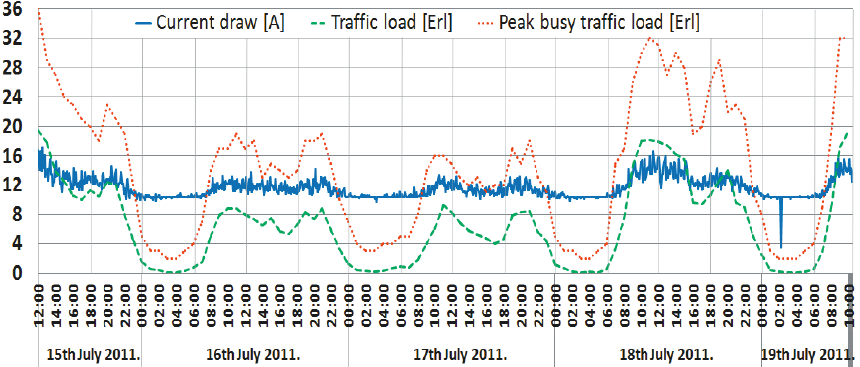
Figure 9. Comparison between electric current draw and traffic load for GSM BS (Sector 2).